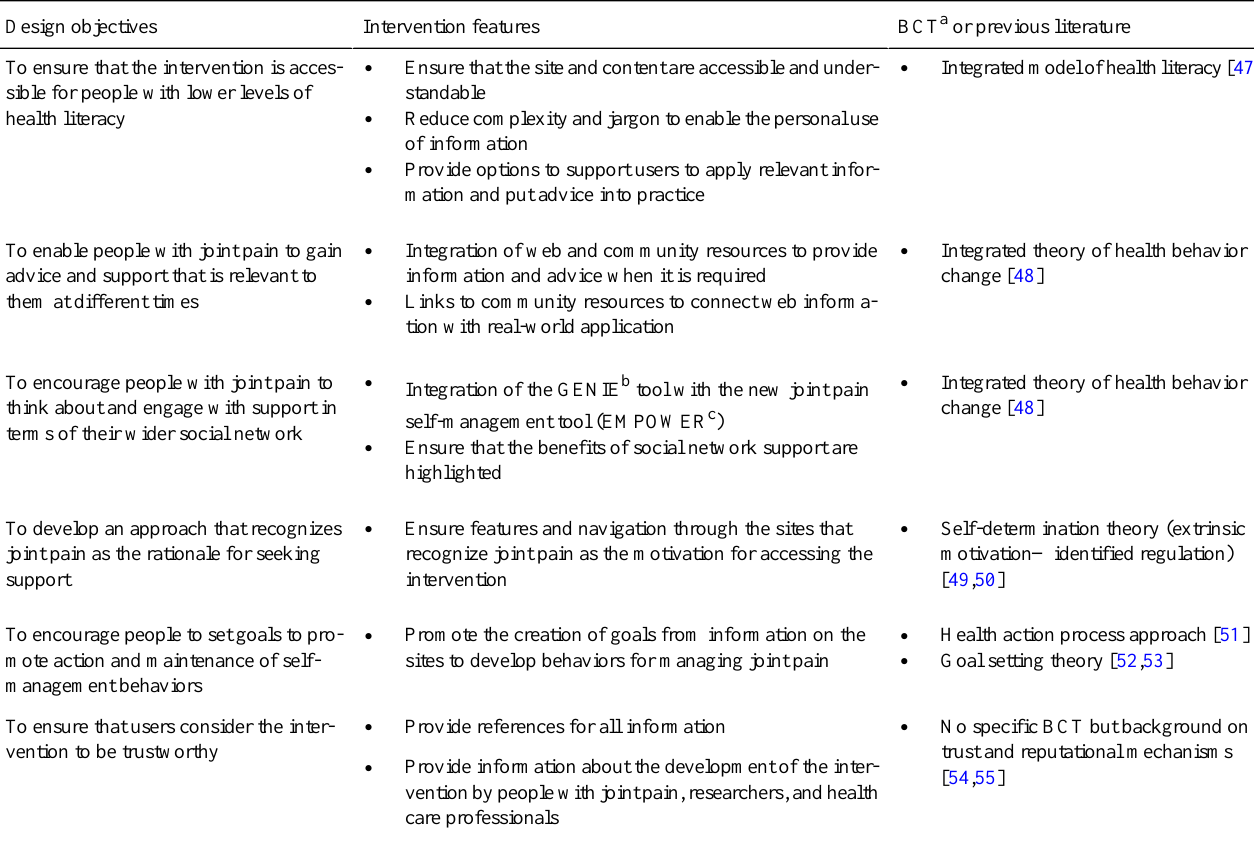
Table 2. Design objectives, intervention features, and background literature or theory linked to the guiding